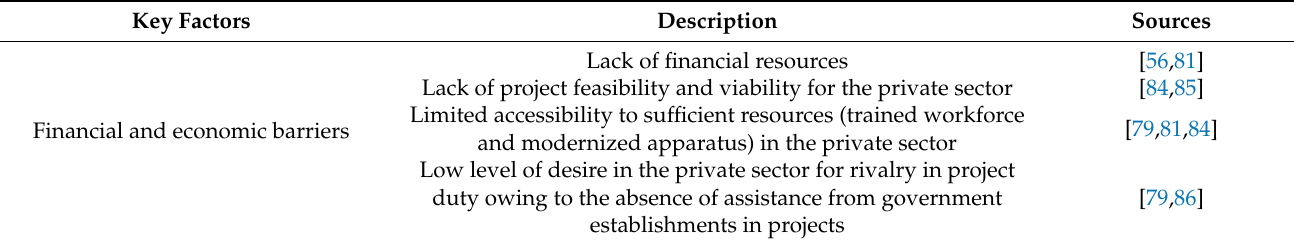
Table 4. Barriers to private sector participation in CE in the built